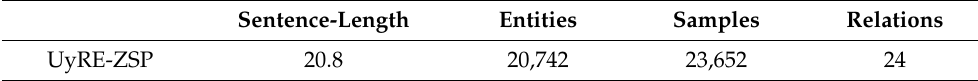
Table 4. Datasets statistics in Uyghur